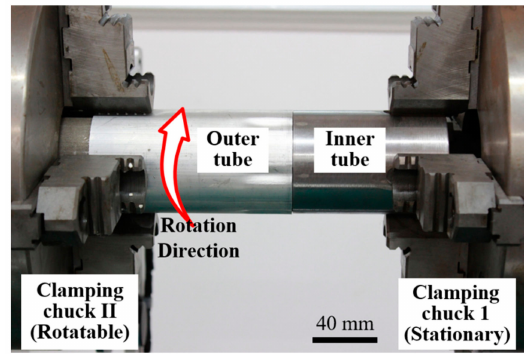
Figure 3. The setup of torsion